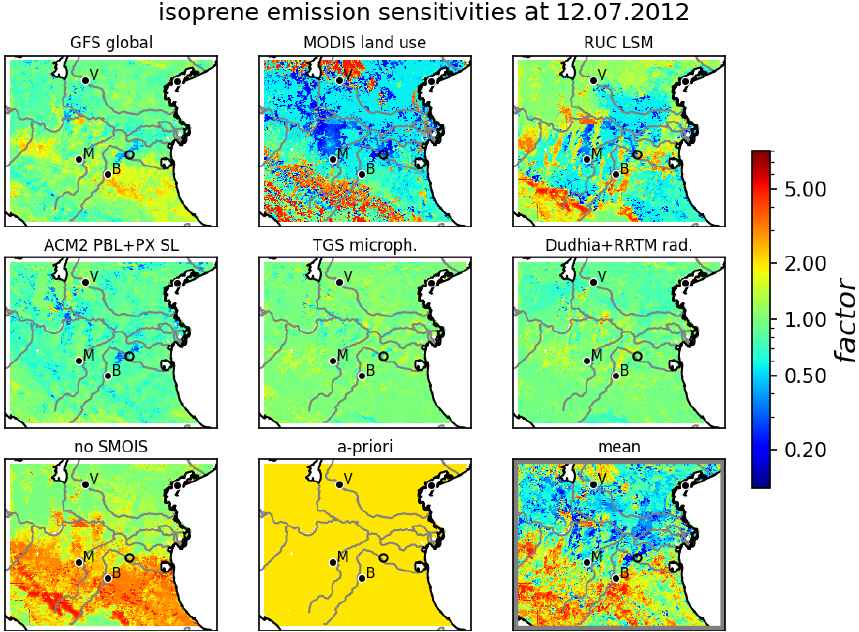
Figure 4. Set of independent sensitivities of isoprene emissions simulated by EURAD-IM. Shown are isoprene emission factors of simula- tions where only one model argument differs from the reference setup. Plotting conventions including abbreviations as in Fig. 3. Additional uncertainties refer to the drought response (no SMOIS) and the emission model (a priori) of biogenic emissions. The lower-right subplot shows the independent mean from these sensitivities using Eq. (10a). A detailed description of the abbreviations and model implementations is provided by Vogel and Elbern (2021a).